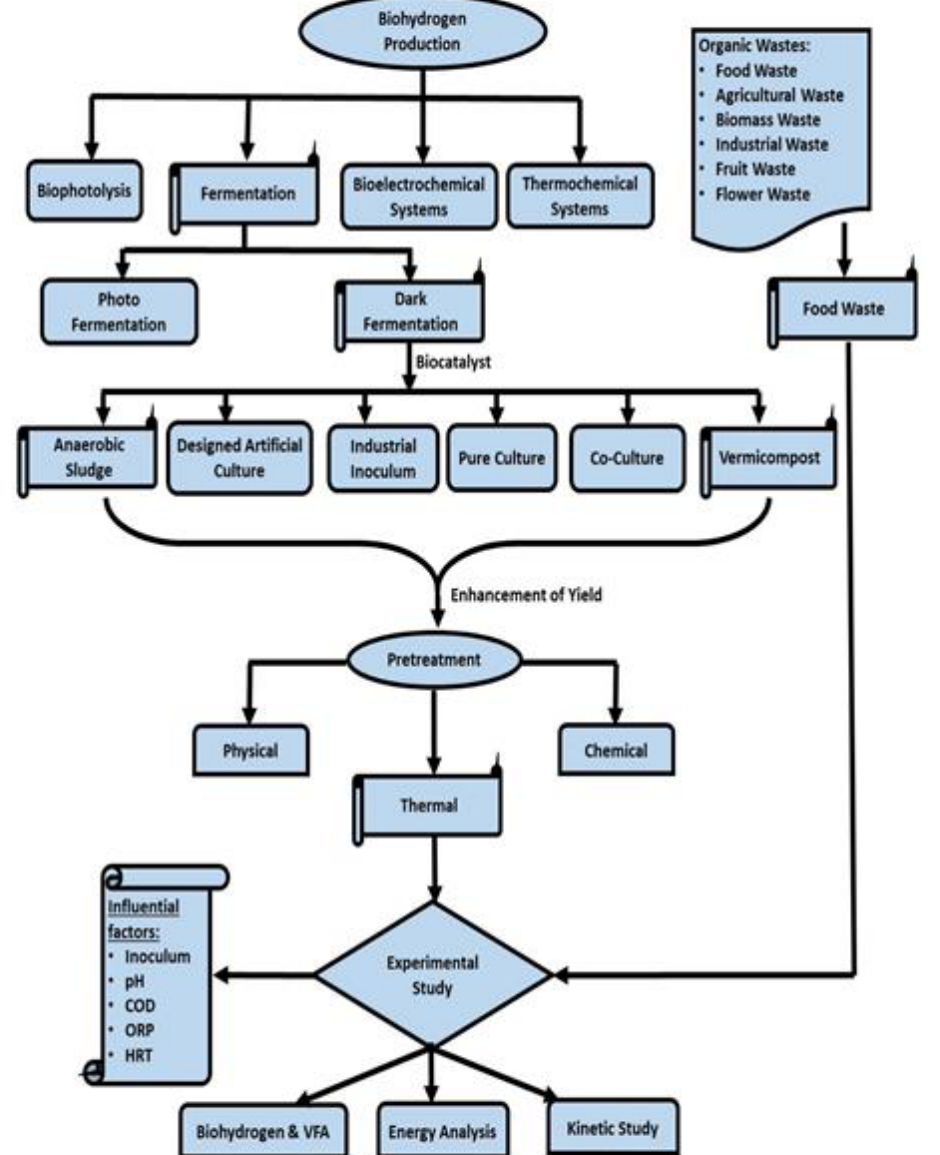
Figure 2. Overview of the biohydrogen production processes and the experiment performed in the study.